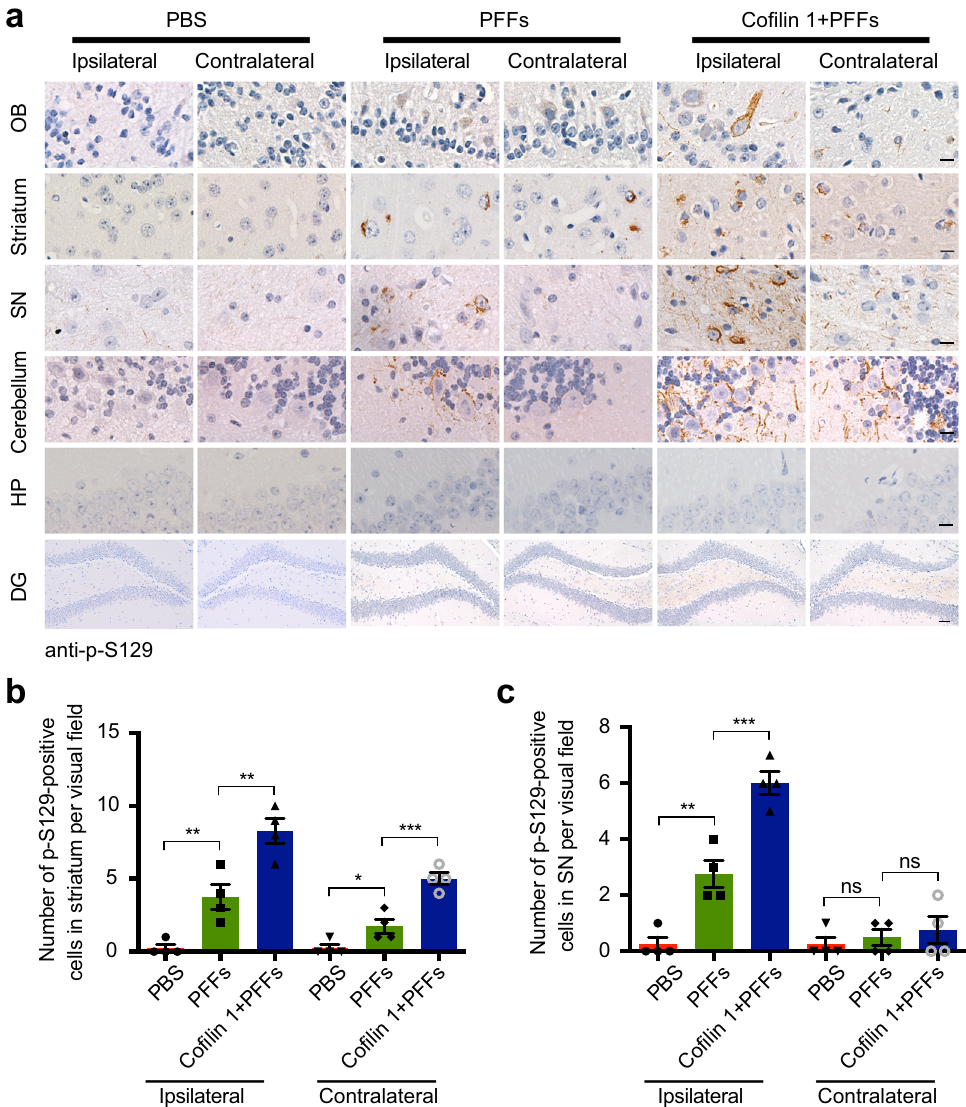
Fig. 4 Co fi lin 1 accelerates the transmission of α -synuclein aggregates in the mouse brain. a – c Immunohistochemistry showing the expression of p-S129 α -synuclein in different brain regions of mice injected with PBS, α -synuclein PFFs, and α -synuclein PFFs together with AAV-co fi lin 1. Scale bar in DG area, 50 μ m. Scale bars in other areas, 20 μ m. Bar graph, quanti fi cation of p-S129-positive cells in the striatum ( b ) and SN ( c ) of mice. Data are mean ± SEM; n = 4; * P < 0.05, ** P < 0.01, *** P < 0.001, ns: not statistically signi fi cant by one-way